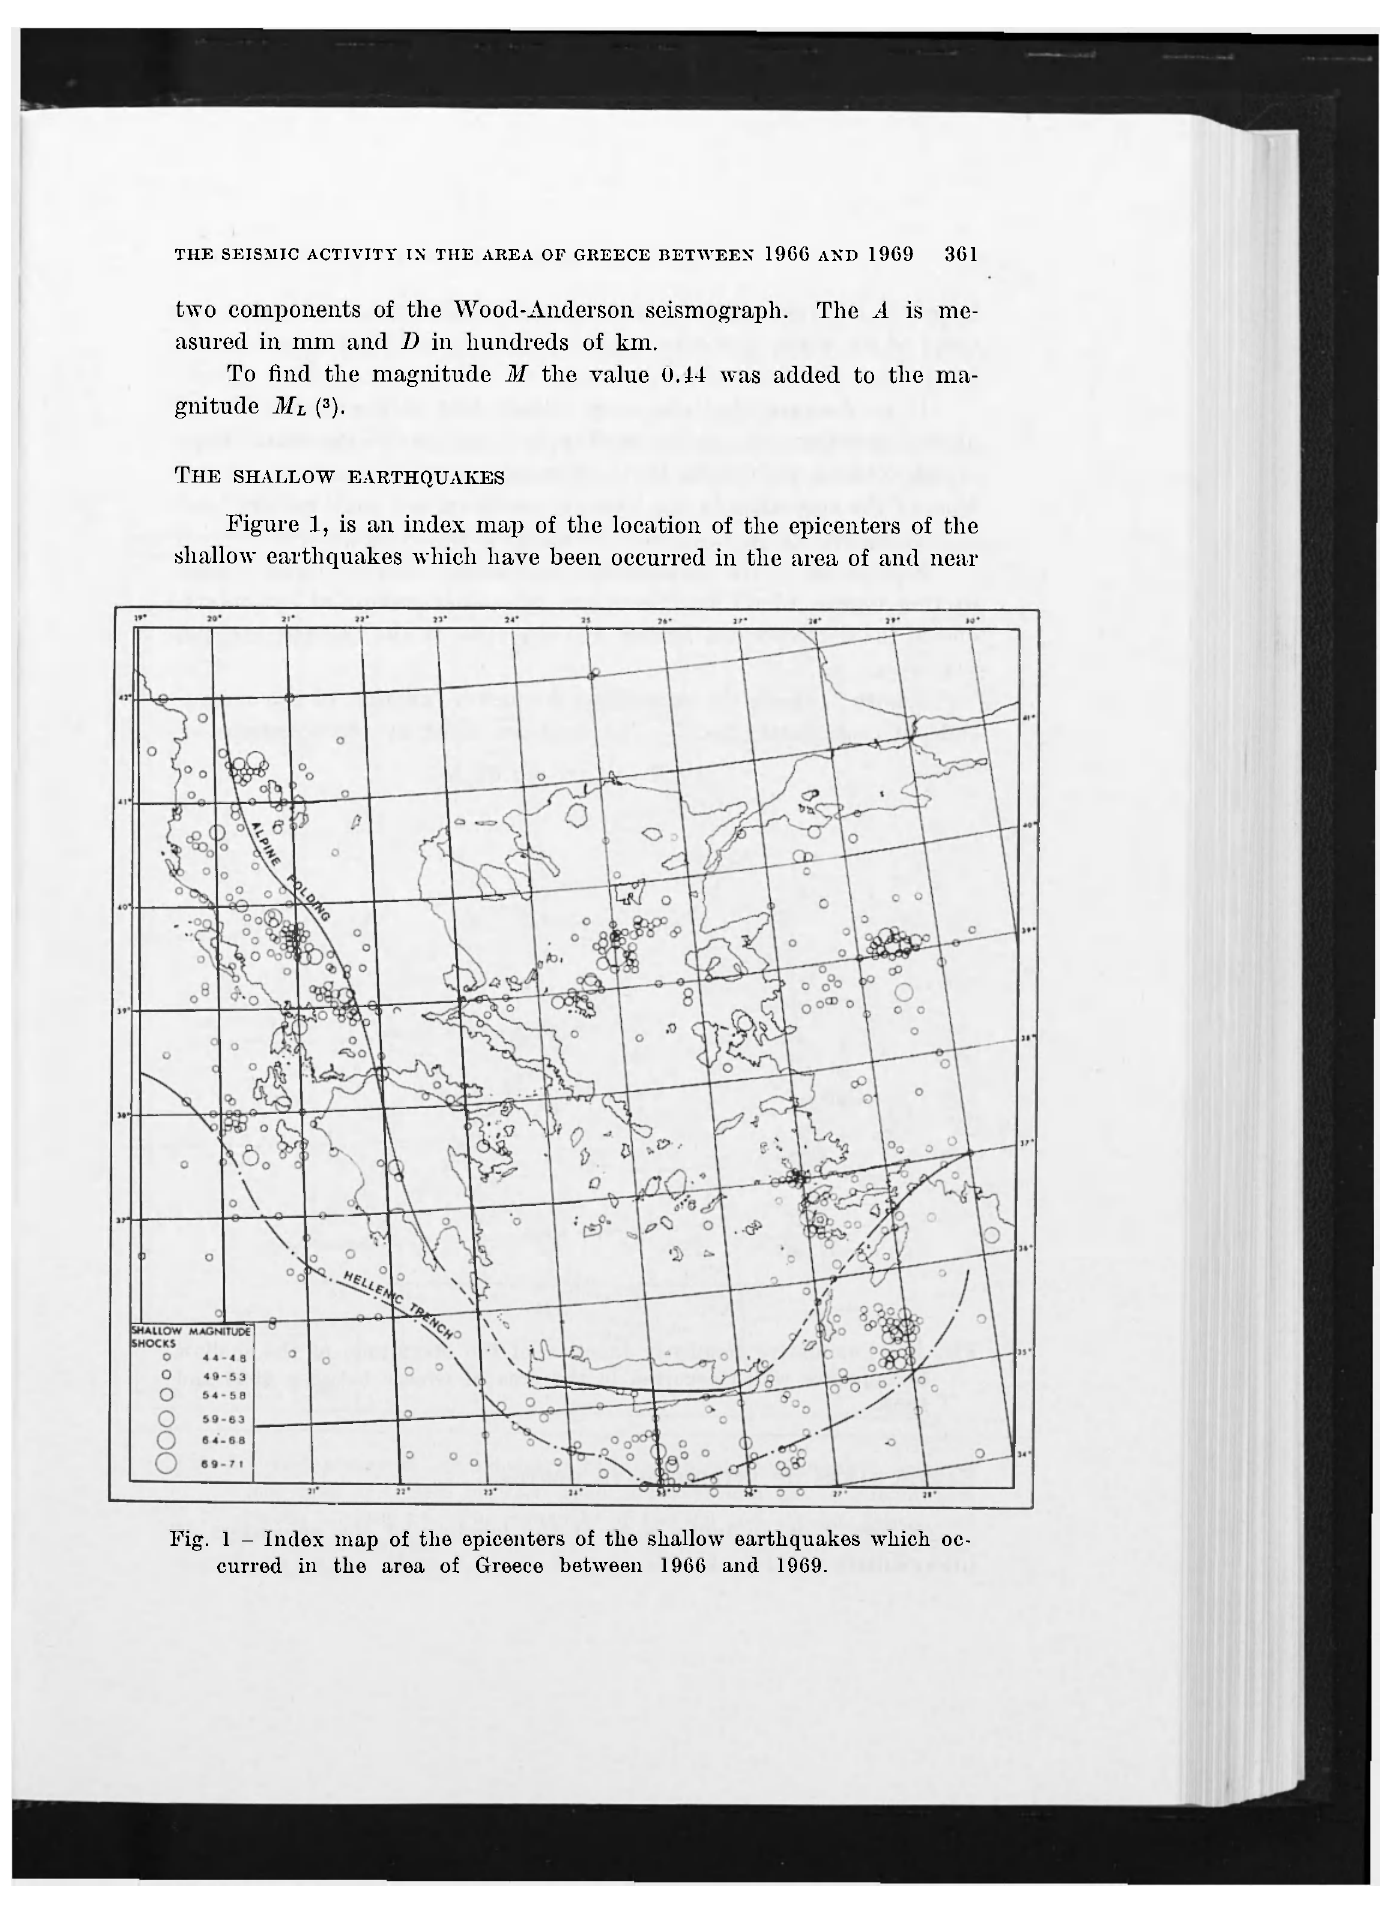
Fig. 1 - Index map of the epicenters of the shallow earthquakes which oc- curred in the area of Greece between 1966 and